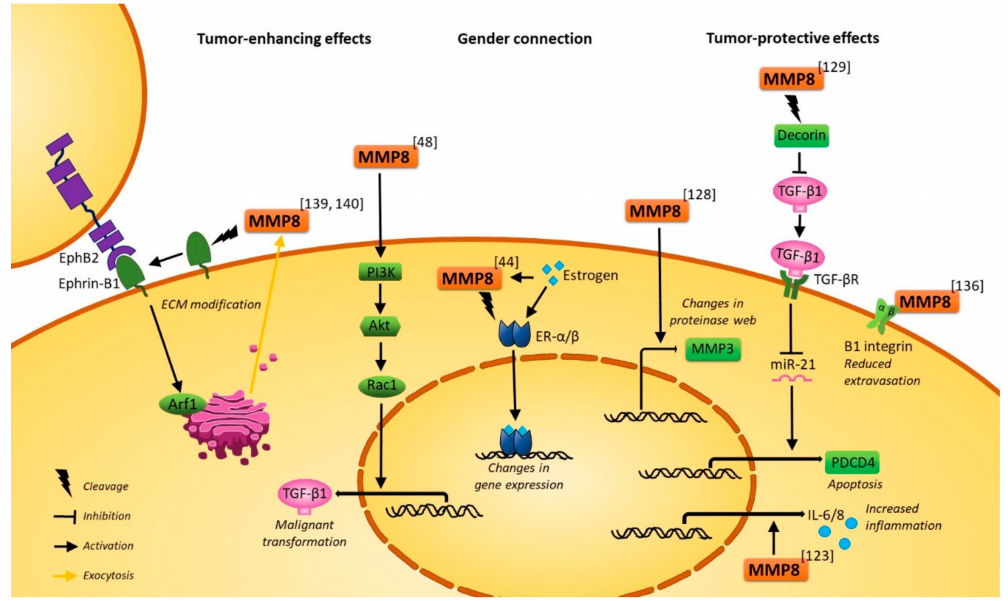
Figure 3. Suggested molecular mechanisms of MMP8. Abbreviations: Akt: RAC- α serine / threonine-protein kinase; Arf1: ADP-ribosylation factor 1; ECM: Extracellular matrix; EphB2: Ephrin type B receptor 2; ER- α / β : Estrogen receptor α / β ; IL-6 / 8: Interleukin 6 / 8; MMP3: Matrix metalloproteinase 3; MMP8: Matrix metalloproteinase 8; PDCD4: Programmed cell death 4; PI3K: Phosphoinositide 3-kinase; TGF- β R: Transforming growth factor β receptor: TGF- β 1: Transforming growth factor β -1. See references (in superscript) for original